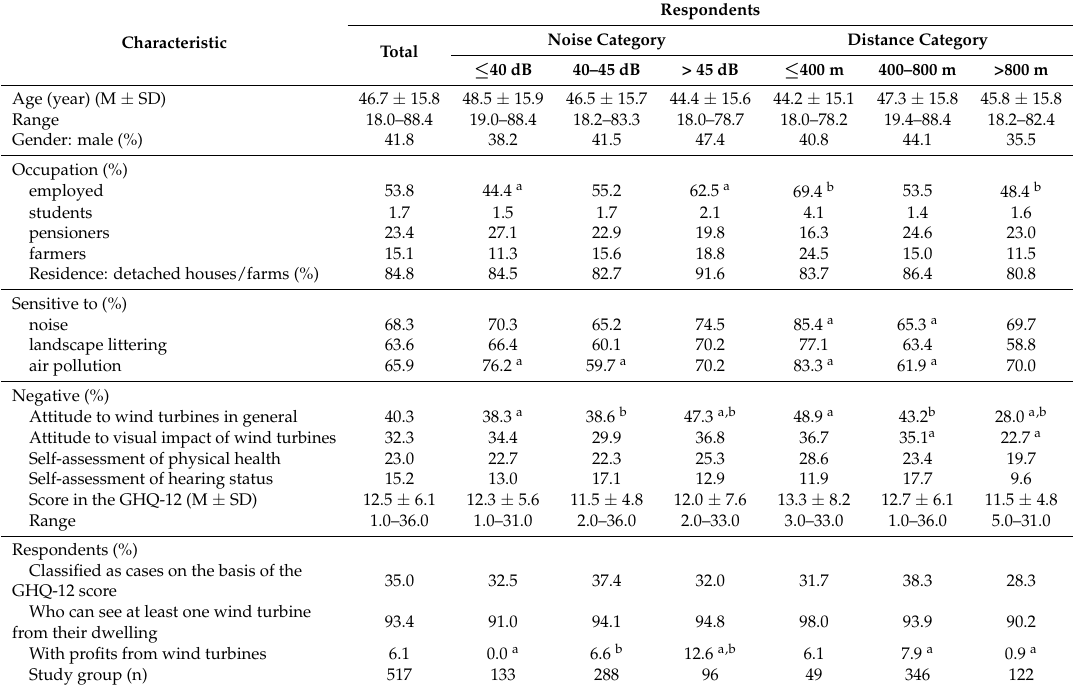
Table 2. Study group characteristics.